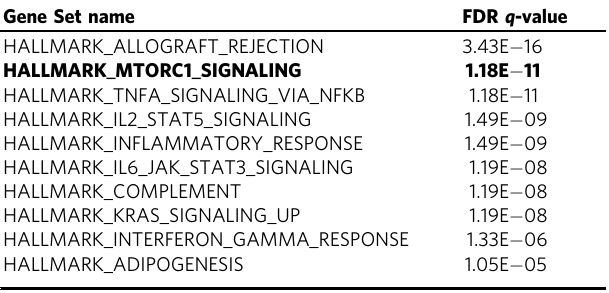
Table 2 Gene set enriched in human drug resistant AML after